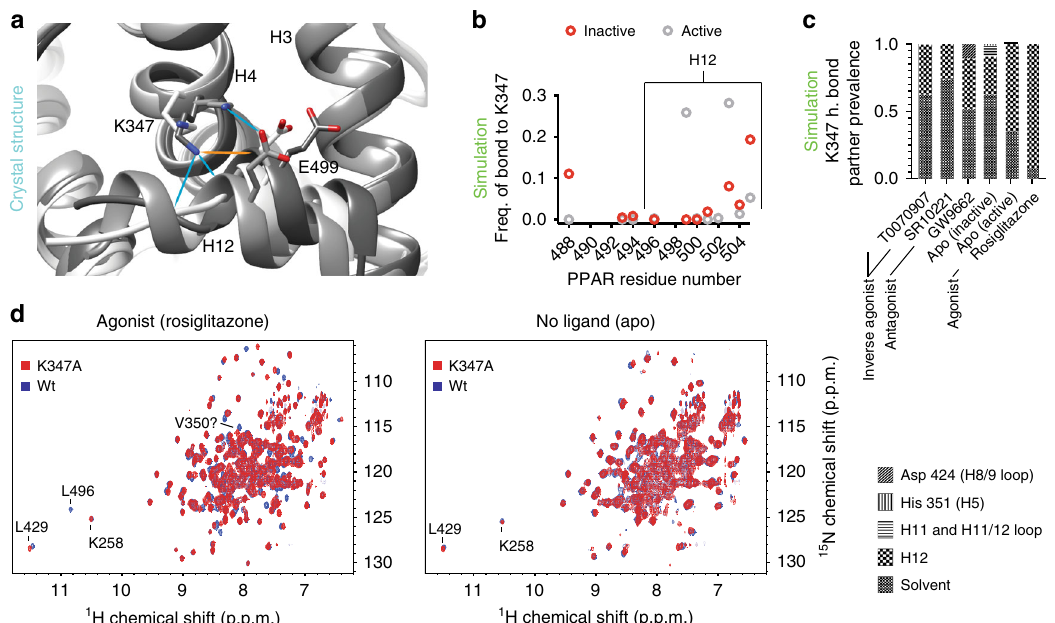
Fig. 3 The apo ensemble contains little active-like helix 12 conformations. a Examples of three classes of helix 4 to helix 12 bonding observed in deposited crystal structures (PDB codes 1PRG, 2PRG, and 3R5N). Almost all of the 176 active structures (chain A) available show bonding between K347 and the helix 12 backbone. Two of the 176 structures have a salt bridge between K347 and E499. None of the 176 inactive conformations (chain B) showed bonding between K347 and helix 12. b All 58 representative structures shown in Supplementary Fig. 1 were subjectively classi fi ed as having active-like or inactive-like helix 12 conformations. Prevalence of bonding between helix 12 residues and K347 calculated from 1 μ s simulations of each representative structure in each class are shown. c The Boltzmann average values for interaction of the terminal side chain protons on K347 (i.e., NH3) and all other residues was calculated for PPAR γ alone (apo) or bound to the indicated ligands. d Comparison of wt and K347A mutants bound to rosiglitazone or without ligand (apo) using TROSY-HSQC NMR. Source data are provided as a Source Data fi le (Source